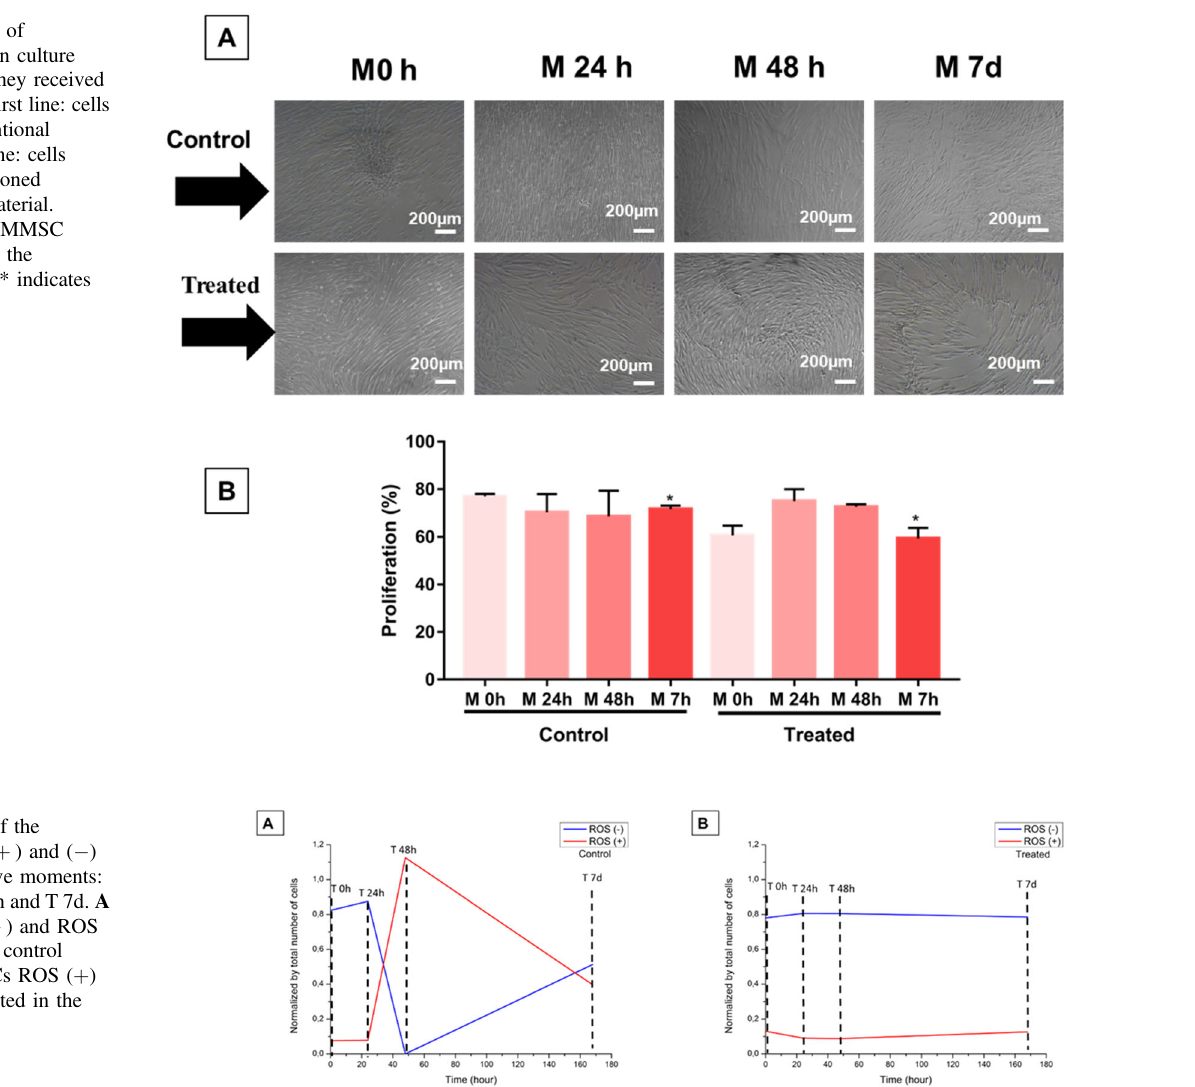
Fig. 7 Micrographs of eBMMSCs plated in culture plate wells where they received the treatments. A First line: cells treated with conventional medium. Second line: cells treated with conditioned medium with biomaterial. B Evaluation of eBMMSC proliferation during the experimental time. * indicates